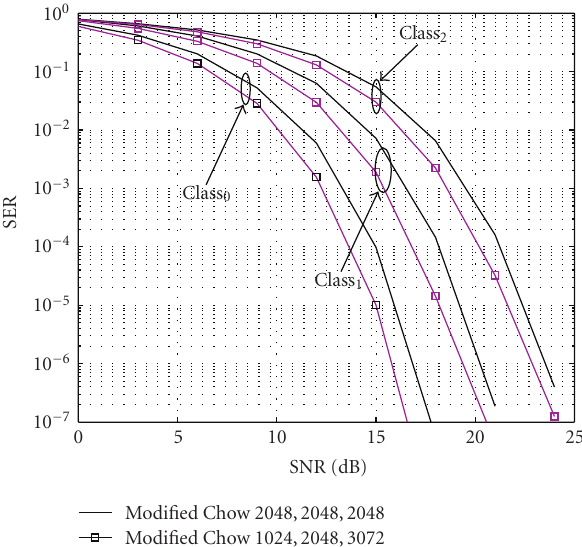
Figure 3: SER performance for the modified Chow algorithm assuming 3 di ff erent classes with margin separations of 3dB, and 6144 bits on 2048 subcarriers with two scenarios: T 0 = 1024, T 1 = 2048, T 2 = 3072, and T j = 2048, j = 0 .